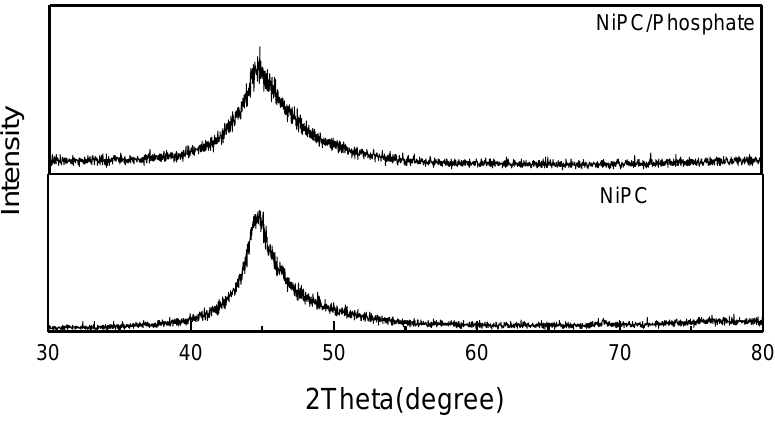
Figure 4. XRD patterns of the NPC and NPC/Phosphate on AZ31B alloy.